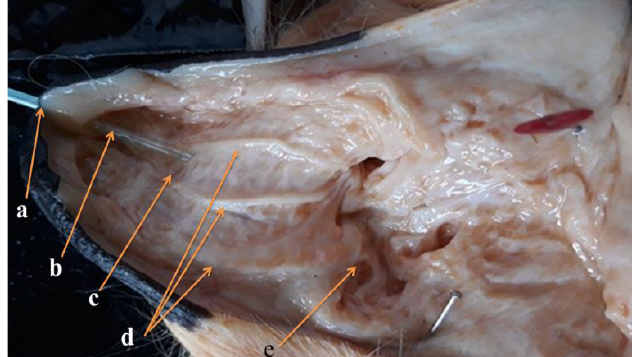
Figure 2. Photograph of opened teat of mammary gland of local Iraqi cow shows: (a) Teat orifice, (b). Teat canal, (c) Teat sinus, d. lactiferous sinus, (e) Longitudinal folds